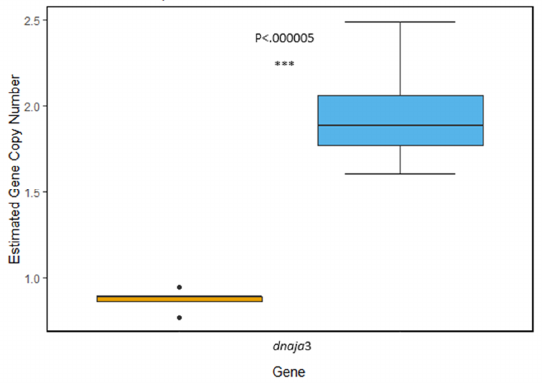
Figure 1. Comparison of estimated gene copy number of the hsp 40 isoform dnaja 3. Average copy number is estimated to be 1.92 copies per haploid genome in T. bernacchii (blue) and 0.875 copies per haploid genome in N. angustata (orange). A highly significant difference between the two means was observed ( p < 0.00005). Box and whiskers represent quartile ranges with circles representing outliers.